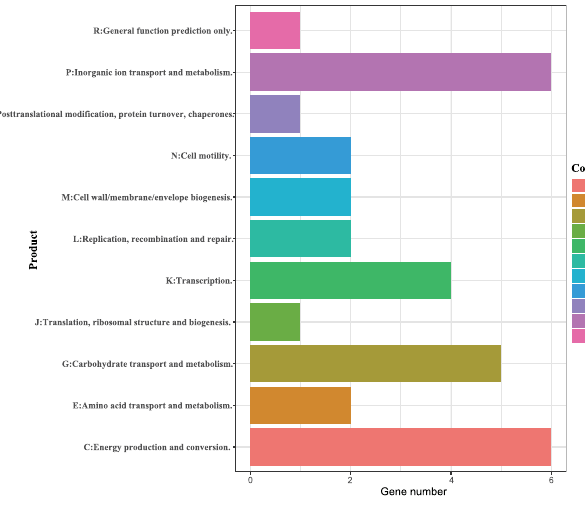
distribution. c shows COG function classi fi cations of SNPs with P <1e-50. These SNPs are mainly associated with transport, energy production, and transcription. Source data are provided as a Source Data fi le. SNP single-nucleotide